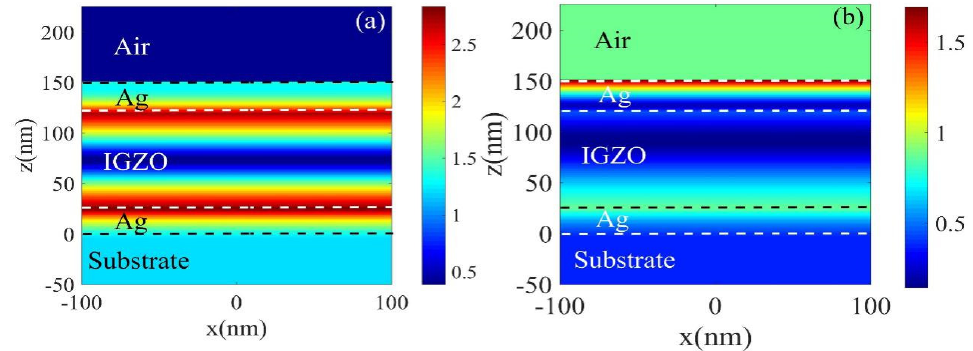
Figure 7. The electric field distribution curve for the color filter (green) with a resonance wavelength of 550 nm in the x − z plane, t = 30 nm, d = 90 nm: ( a ) before H 2 treatment; ( b ) after H 2 treatment.